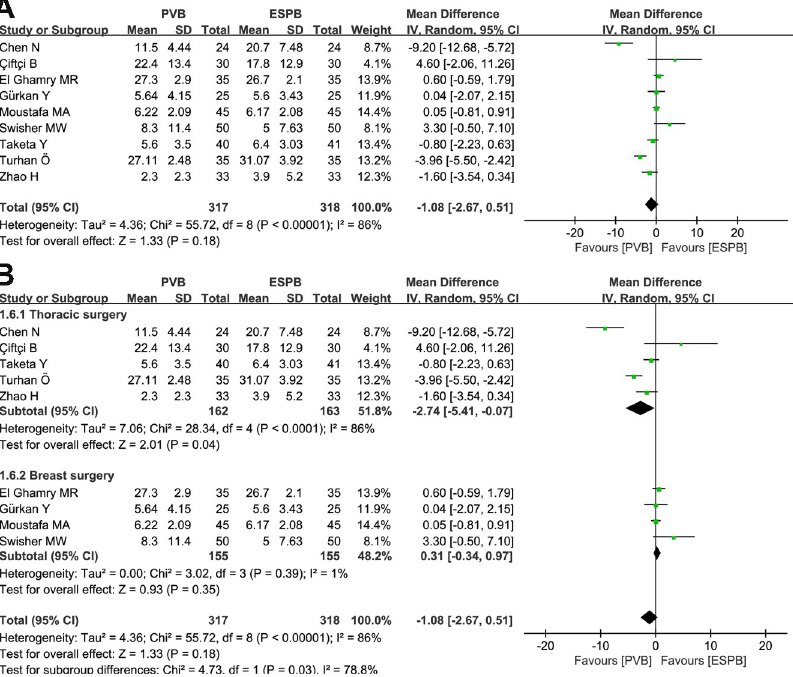
Fig 6. Forest plots of the opioid consumption at 24 postoperative hours. (A) Analysis of all data in the associated studies; (B) Subgroup analysis by differentiating thoracic surgery or breast surgery.